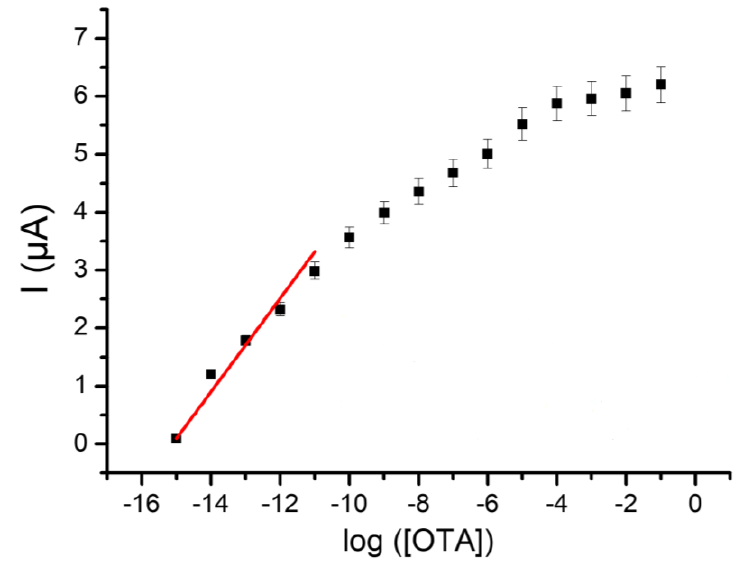
Figure 8. Calibration curve of the HRP sensor versus log OTA concentration.